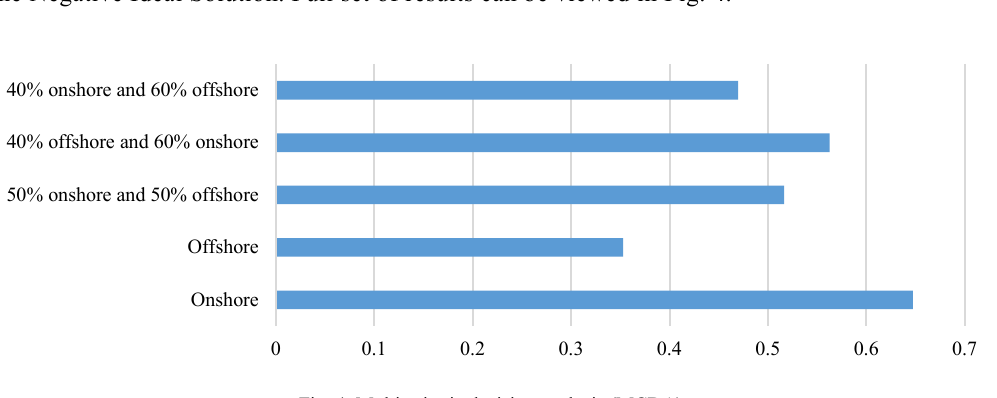
Fig. 4. Multi-criteria decision analysis